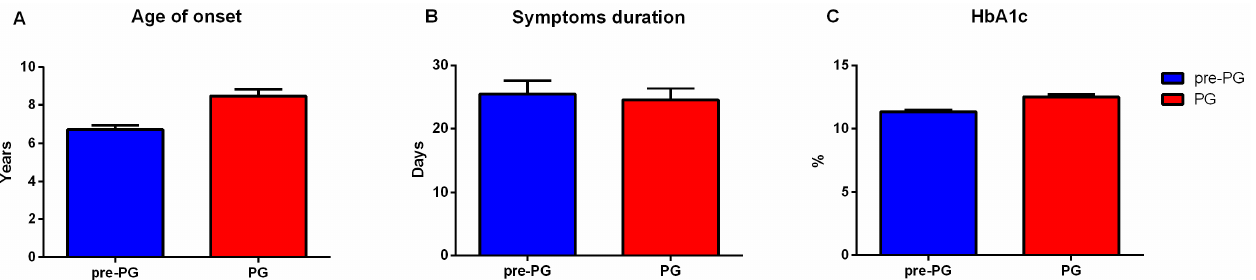
Figure 2. Comparison between the pre-pandemic (pre-PG) and pandemic group(PG) of patients based on several parameters. ( A ) Age of onset; ( B ) Symptoms duration; ( C )